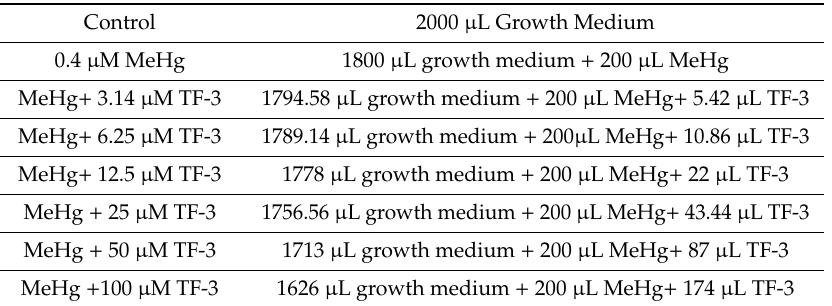
Table 3. Liquid media composition of culture well